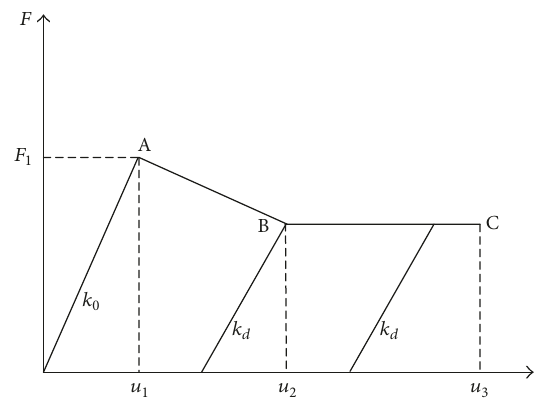
Figure 10: Mechanical model of U-SLEBs considering degradation.